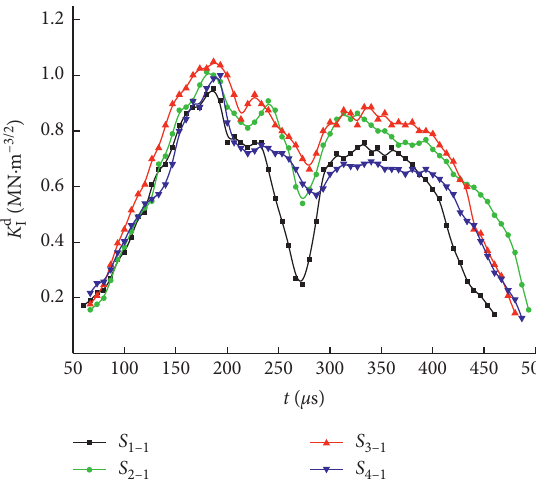
Figure 9: Curves of mode I stress intensity factor with